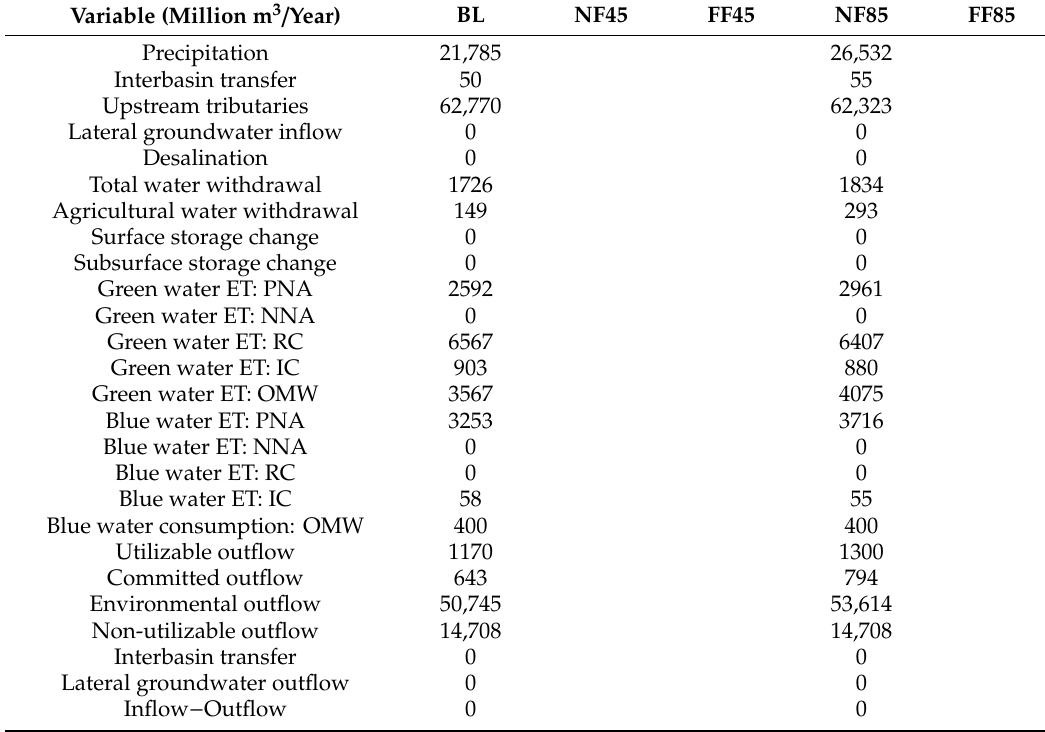
Table A6. Resource base sheet of the Delta Rhine river basin area, The Netherlands 1